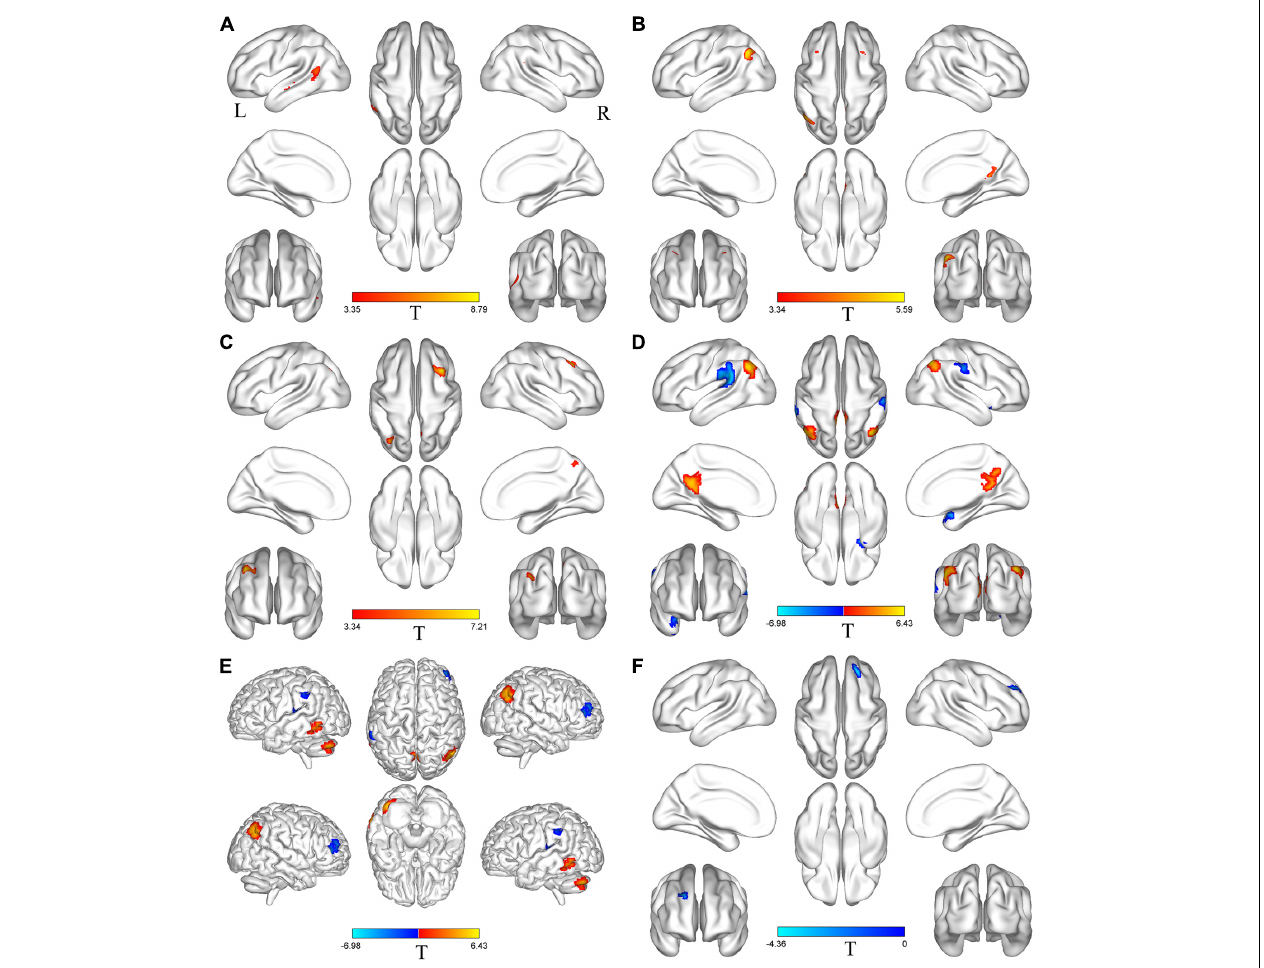
FIGURE 2 | Brain regions with altered FC between the PD-Pre-DBS group and the PD-Post-DBS group. Left middle temporal gyrus (A) , Right precuneus (B) , Right angular gyrus (C) , Left middle frontal gyrus (D) , Right dorsolateral prefrontal cortex (E) , Right inferior frontal gyrus (F) as ROIs and performed a voxel-wise analysis of the whole brain FC; Regions showing increased FC in red and decreased FC in blue; L and R represent left and right hemispheres, respectively; The results were corrected by multiple comparisons of the family-wise error (FWE) (voxel p < 0.001, cluster p < 0.05); FC, functional connectivity; PD-Pre-DBS, three days before DBS, PD-Post-DBS, one day after DBS, each time in the off medication and absence of neurostimulation; PD, Parkinson’s disease; DBS, deep brain